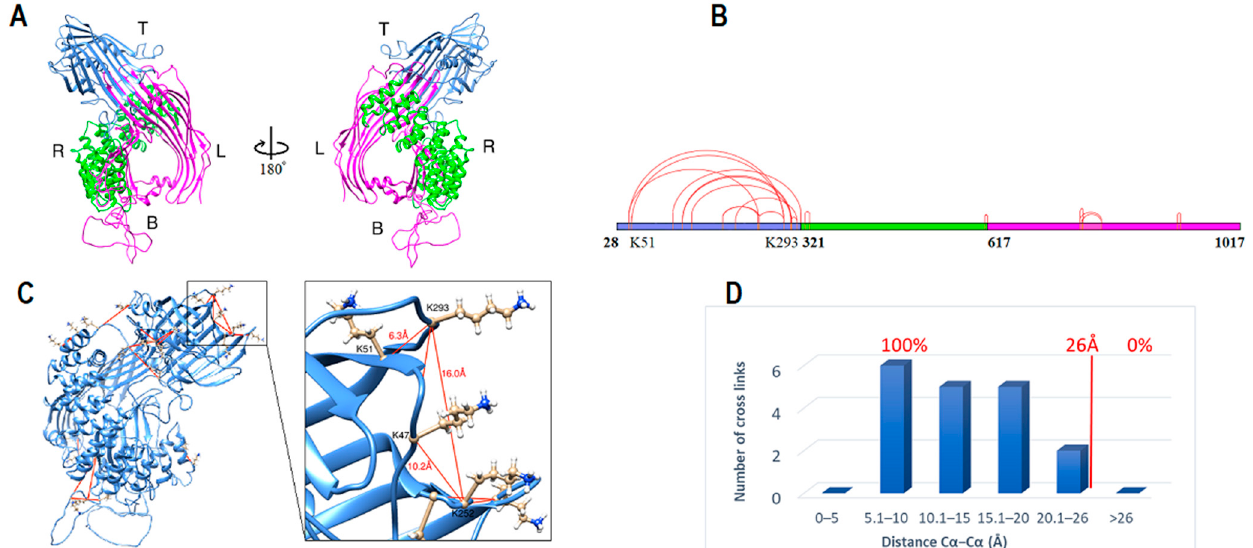
Figure 1. ApoB-100 subunit-I structure and cross-link map. ( A ) Ribbon representation of ApoB-100 subunit I structure. The anterior view of subunit I followed by 180° rotation (posterior view). Domain 1 forms an incomplete β -barrel at the top (blue). Domain 2 with an α -helices on the right (green) and domain 3 forms the left side and the base (magenta). ( B ) DSSO cross-link map on subunit I linear sequence with three domains is colored according to A. ( C ) DSSO cross-link map on subunit I ribbon representation with 18 intra-subunit cross-links (red lines) between lysine residues. ( D ) The distribution plot of identified DSSO cross-links in subunit I vs. the spatial distances of lysine residues in the computational model.